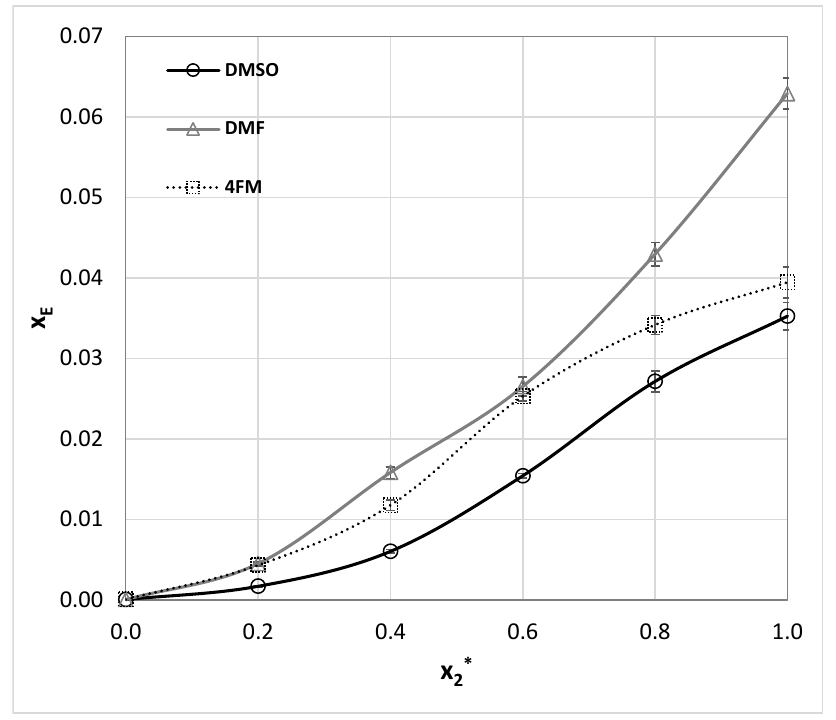
Figure 7. The results of ethenzamide solubility measurements (molar fraction, x E ) at room temperature in aqueous DMSO, DMF, and 4FM mixtures (x 2 * stands for the organic component mole fraction in the binary solvent). The error bars denote standard deviation values ( n = 3).